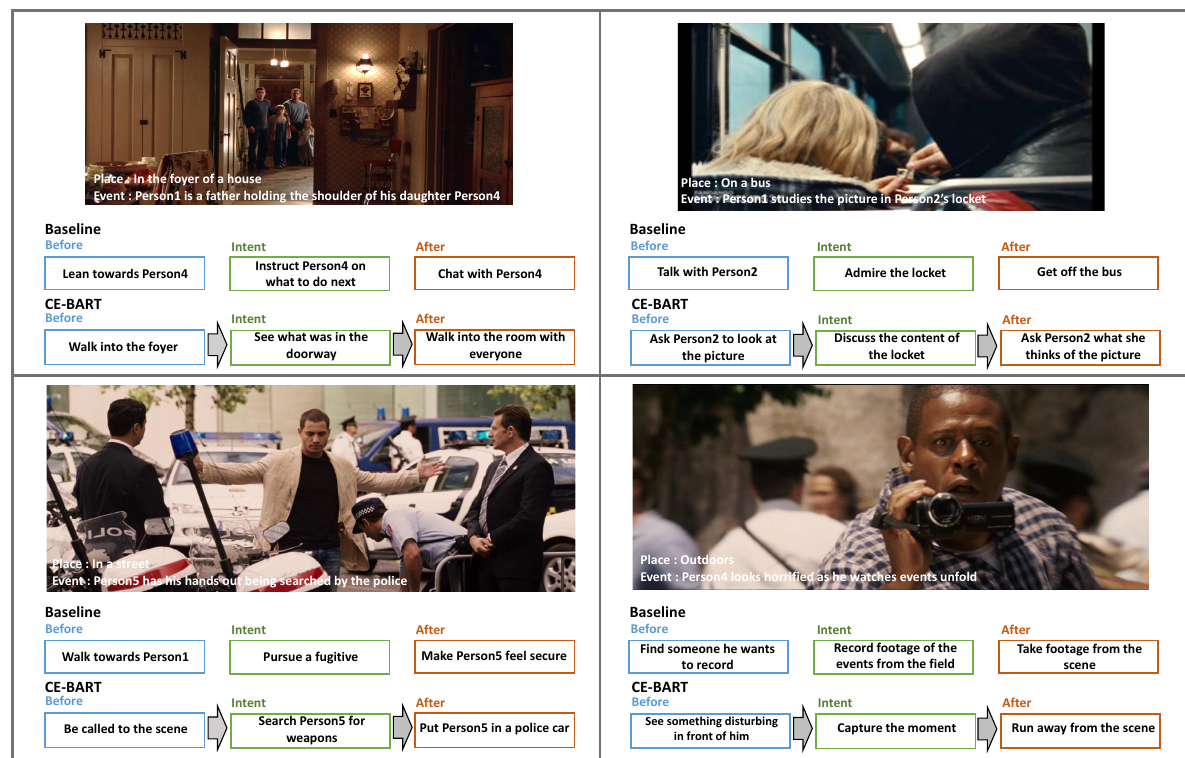
Figure 3. Four examples from the test split of the VisualCOMET